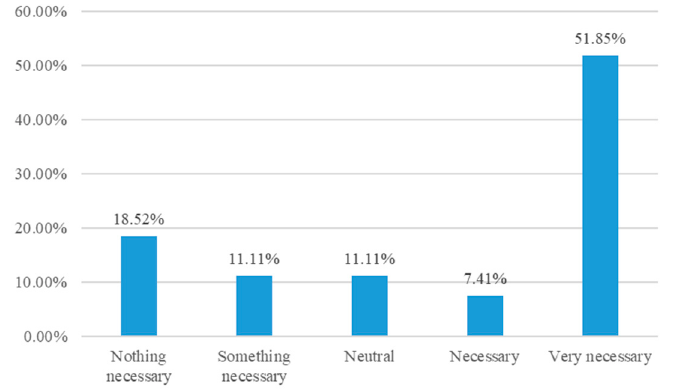
Figure 12. Assessment of whether the network needs to be improved.